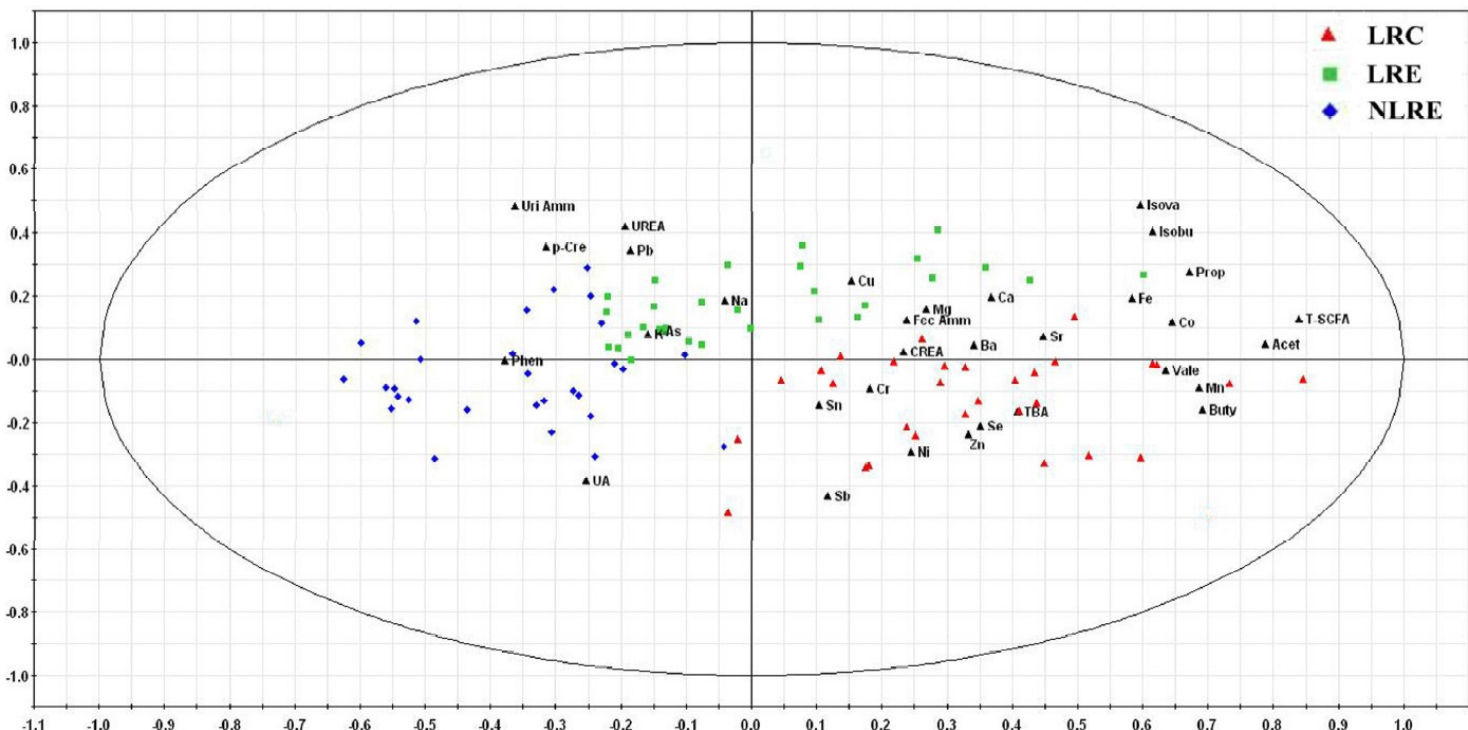
Figure 3. Bi-plot from the partial least squares-discriminant analysis of overall indexes including the metabolites and elements in the three groups. Red triangles represent the participants in the LRC group. Green squares represent the participants in the LRE group. Blue rhombuses represent the participants in the NLRE group. Their spatial distribution reveals the variations of the metabolites and element profiles among the three groups. The three groups exhibit a clear separation, indicating that there are differences in the metabolites and element profiles among the three groups. Moreover, the bi-plot showed that the contents of some beneficial components, such as short chain fatty acids (SCFAs), Mn, Co, Zn and Se, in the LRC group were higher than those in the other two groups. Meanwhile, the contents of some harmful components, such as p -cresol, phenol and ammonia, in the NLRE group were higher. LRC, centenarians from longevous region; LRE, elderly people aged 80–99 years from longevous region; NLRE, elderly people aged 80–99 years from a non-longevous region; Acet, acetic acid; Prop, propionic acid; Buty, butyric acid; Isobu, isobutyric acid; Vale, valeric acid; Isova, isovaleric acid; T-SCFA, total SCFA; TBA, total bile acids; Phen, phenol; p -Cre, p -cresol; UA, uric acid; CREA, creatinine; Fec Amm, fecal ammonia; Uri Amm, urinary